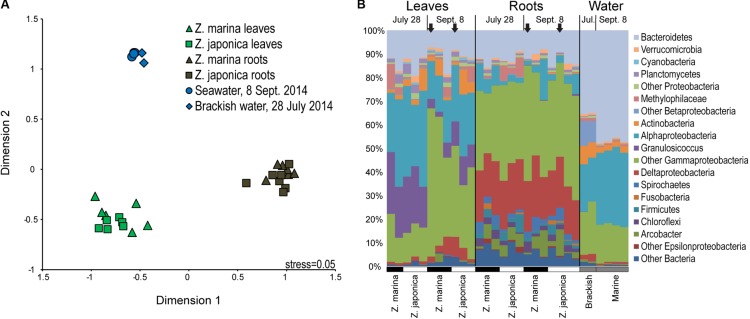
Multidimensional scaling diagram (A) showing beta-diversity of plant-associated and water column bacterial communities based on Bray–Curtis similarity calculated from the relative abundances of 16S rRNA gene amplicon sequences grouped into operational taxonomic units (OTUs) based on 97% DNA sequences similarity. (B) Taxonomic diversity of plant-associated and water-column bacterial communities based on 16S rRNA gene amplicon sequences grouped by major taxa with samples labeled by tissue type, date, and plant species. The black arrows indicate samples used for metatranscriptomics.